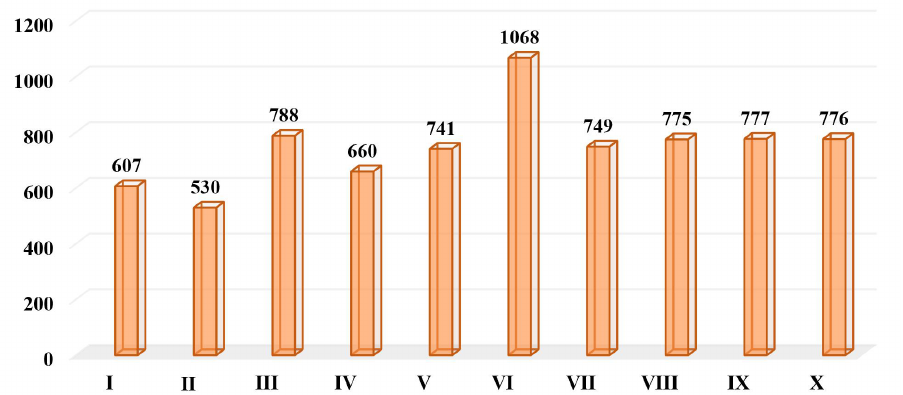
Figure 4. Statistical results for the entire vectorized map dataset.